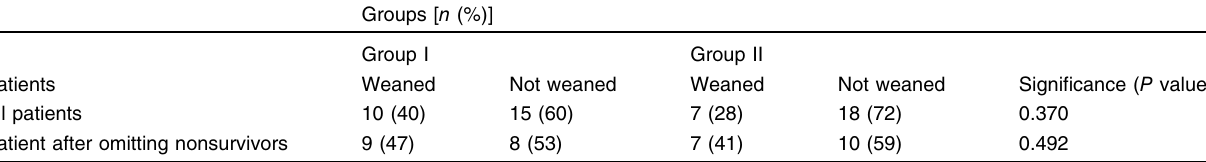
Table 14 Comparison between the two groups regarding patient weaning success using the Pearson’s χ 2 -test